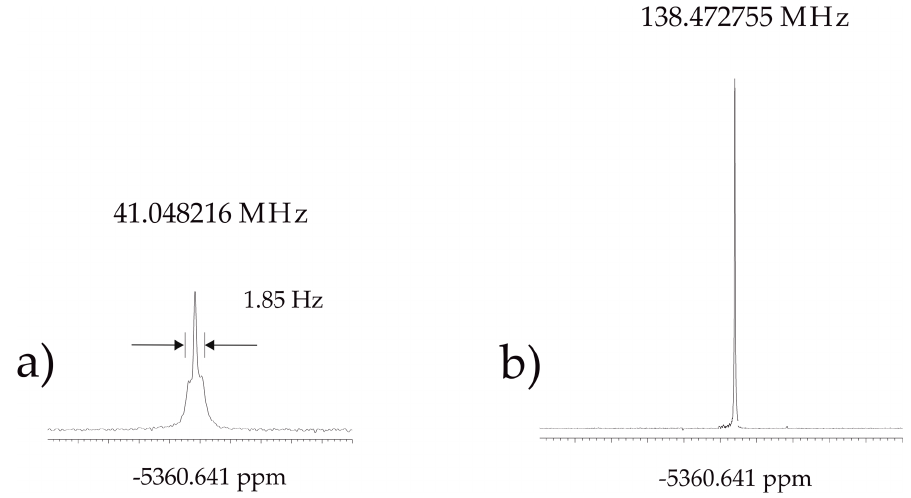
Figure 4. ( a ) 131 Xe and ( b ) 129 Xe NMR signals from gas phase measurements at 31.51 atm (1.3 mol / L) and magnetic field 11.75 T. Specific additional splitting in the 131 Xe resonance is clearly